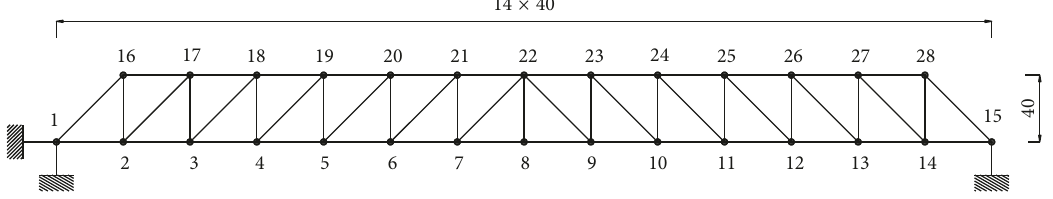
Figure 2: Elevation view of the truss bridge (unit: